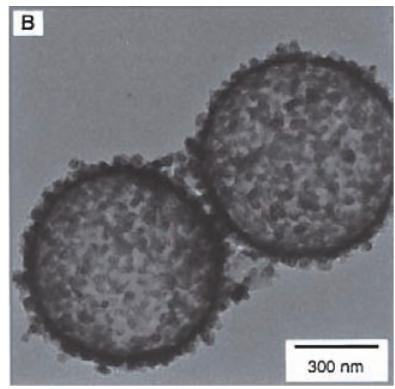
Fig. 2 TEM micrograph of hollow SiO 2 particles pre- pared by organic bead template 24)